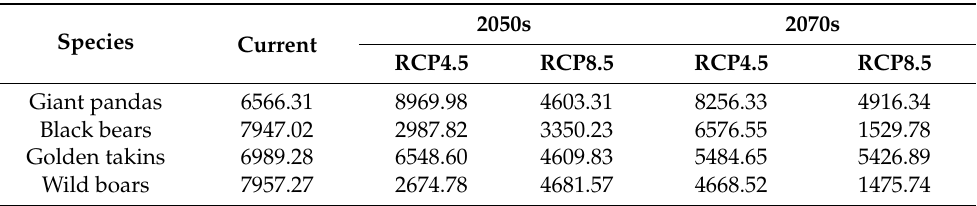
Table 2. Statistics on the areas of suitable habitats for giant pandas and sympatric competitive species under different climate